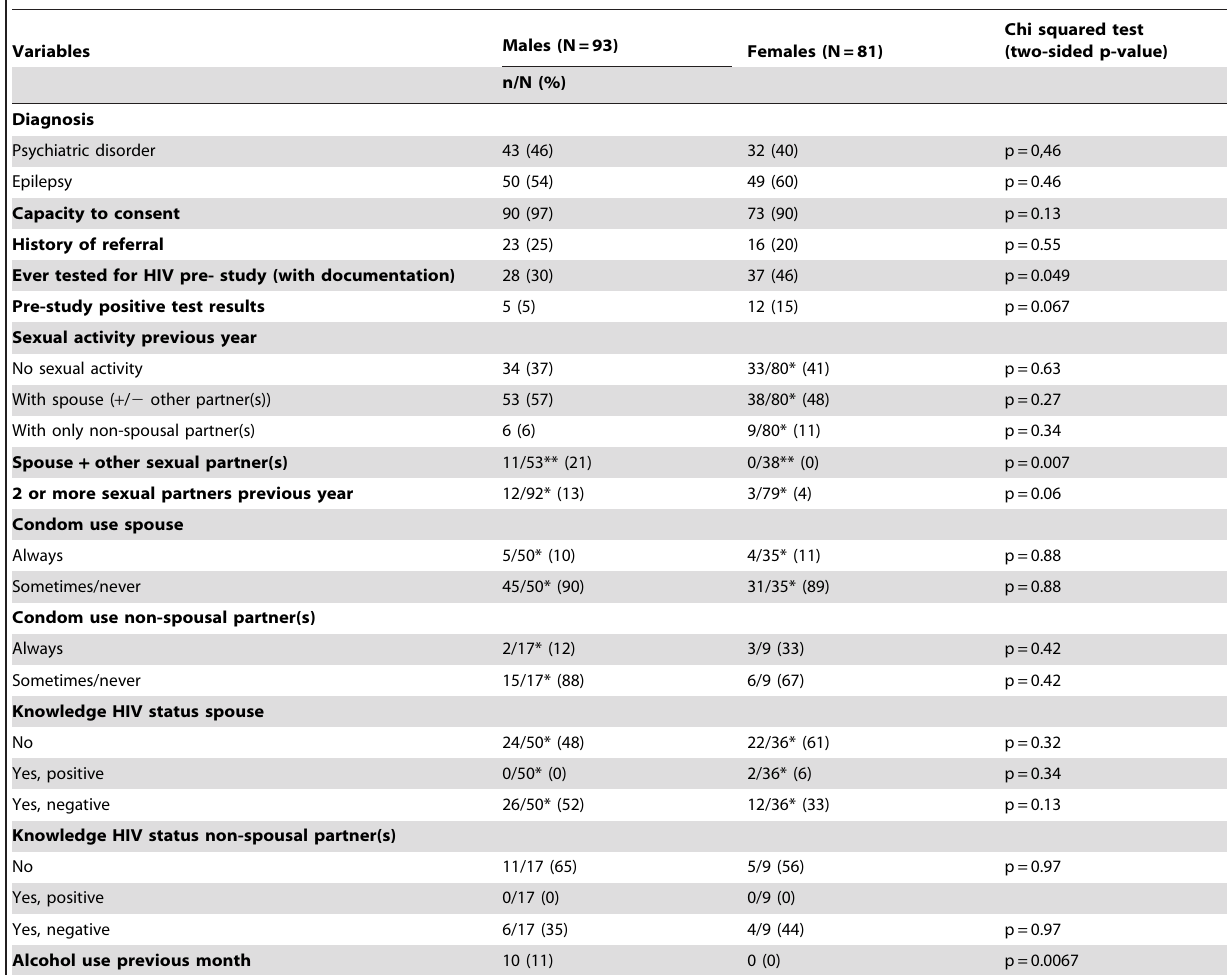
Table 2. Possible risk factors for HIV acquisition according to sex.